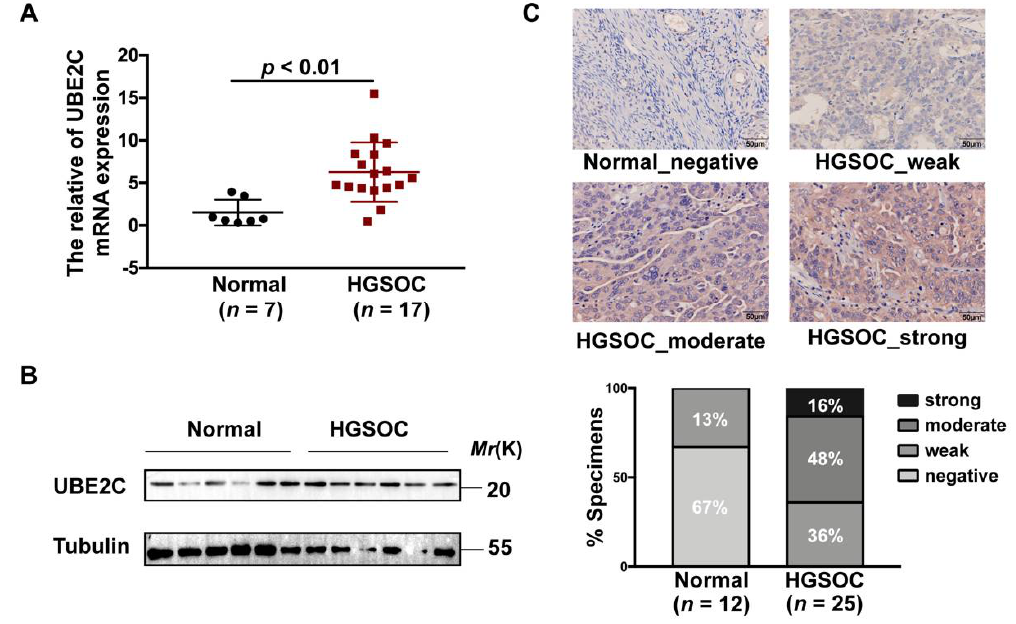
Figure 6. The upregulation of UBE2C in HGSOC tissues. ( A ). The mRNA expression levels of UBE2C